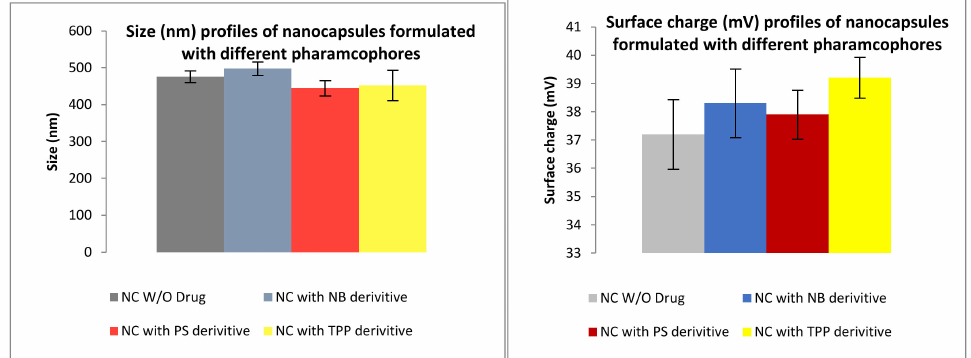
Figure 11. Size and surface charge characteristics of PPY-CHIT nanocapsules (NC) formulated via copolymerization for compound 2 (TPP), compound 4 (NB) and compound 6